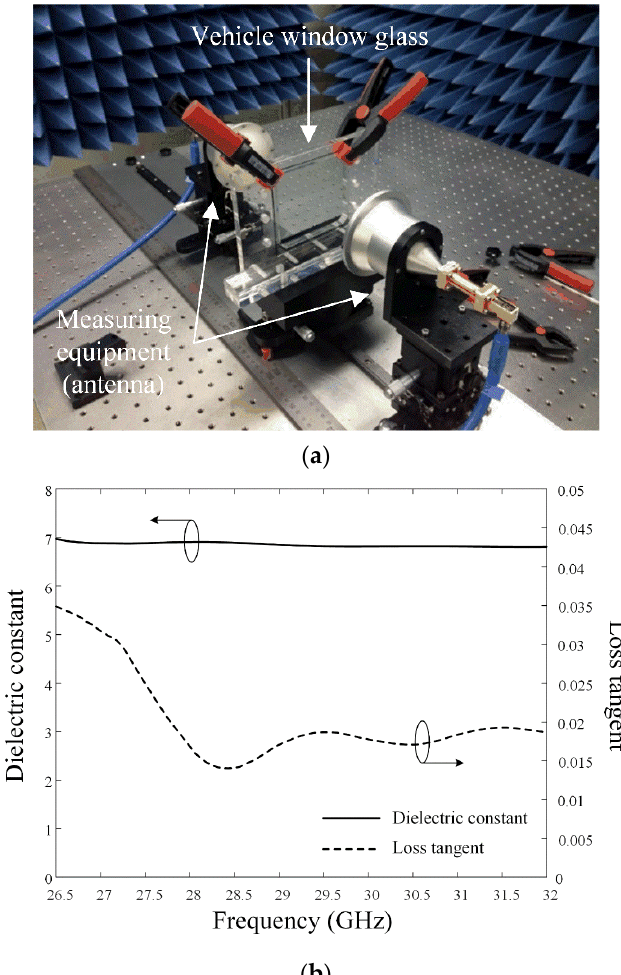
Figure 3. Photographs of the proposed antenna and measurement setup: ( a ) top view; ( b ) bottom view; ( c ) measurement setup.